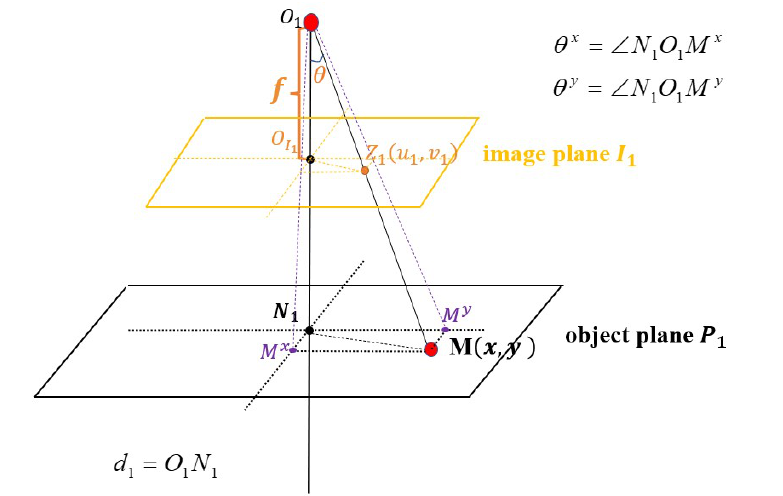
Figure 6. The spatial relationships among the object plane P 1 , image plane I 1 , and the optical axis O 1 N 1